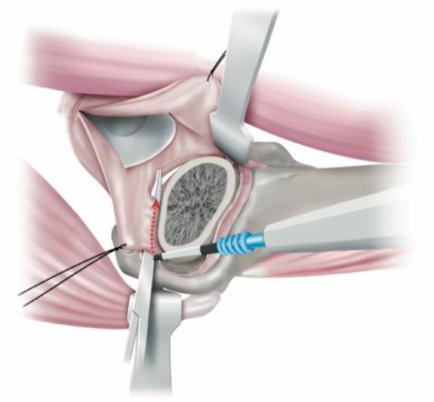
Figure 3. Incision of the ischiofemoral ligament.